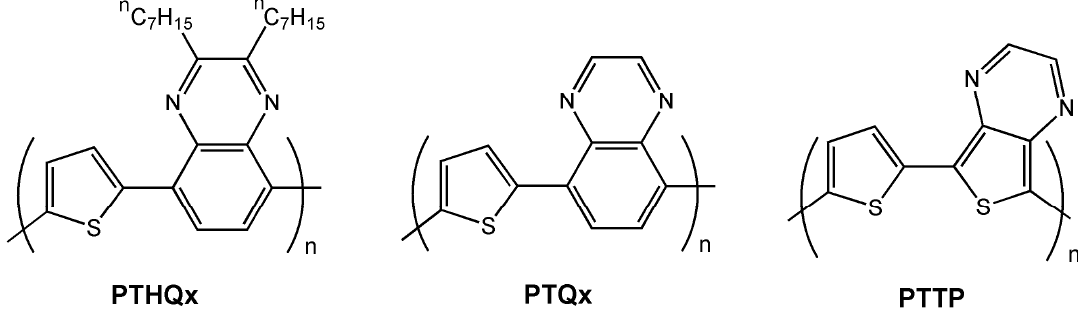
Figure 10. Chemical structures of the semiconducting polymer PTHQx and theoretical model structures PTQx and PTTP